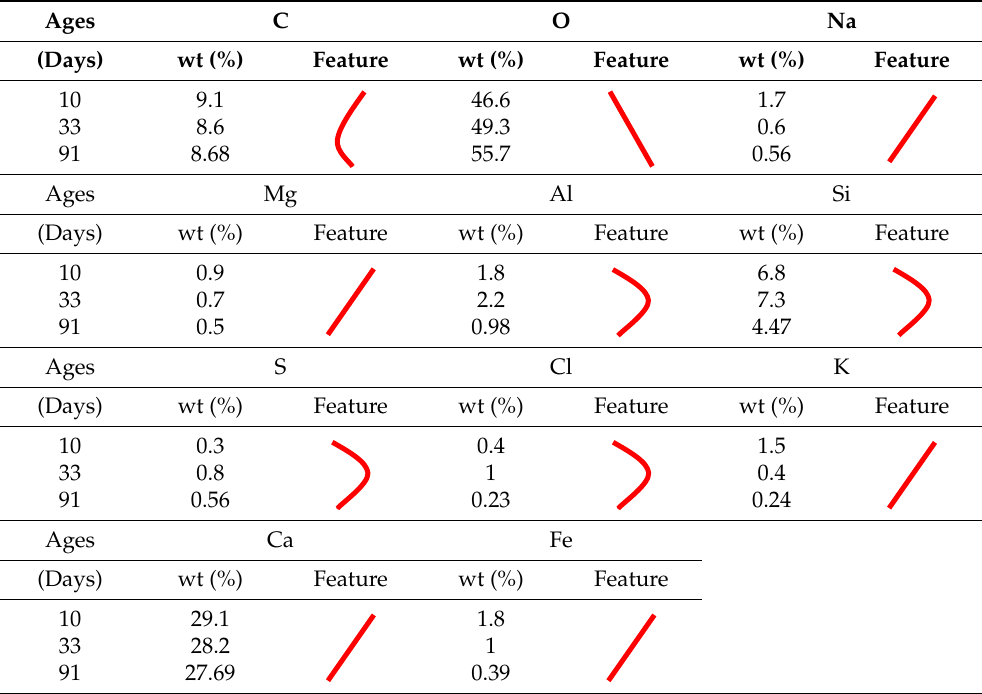
Table 3. Elements’ content and distribution feature from EDS analysis.